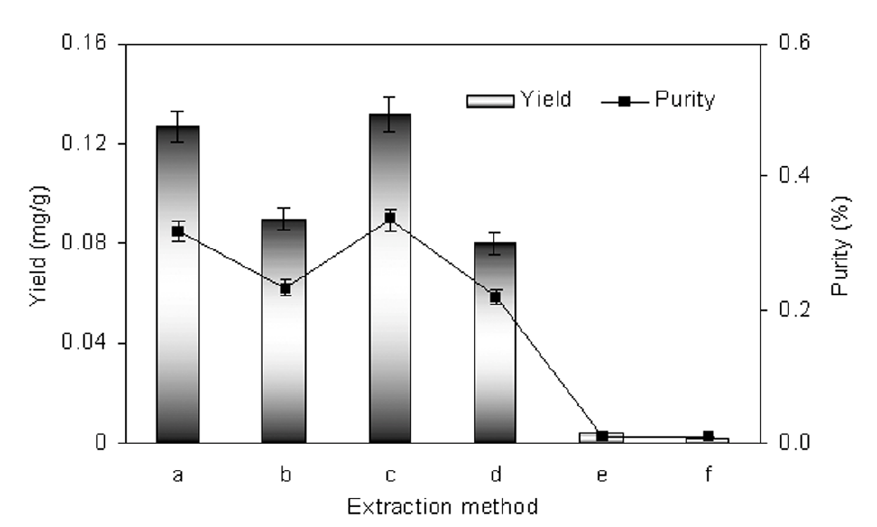
Figure 7. Comparison of homogenate extraction with other extraction methods, mean ±